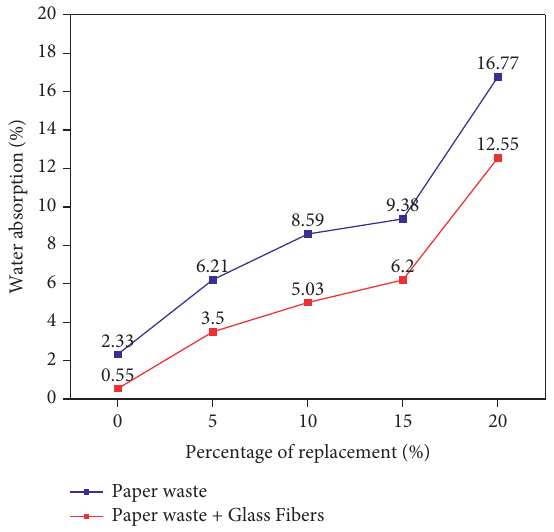
Figure 5: Water absorption test